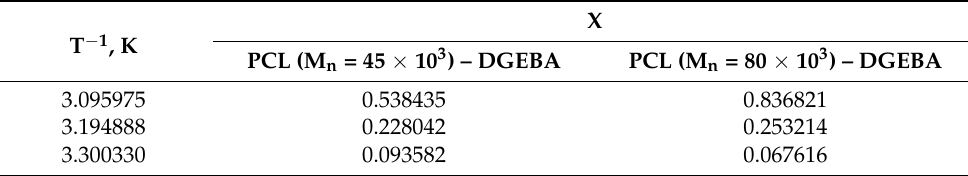
Table 1. Values of the Flory–Huggins pair interaction parameter calculated from the melting point depression of PCL in the presence of